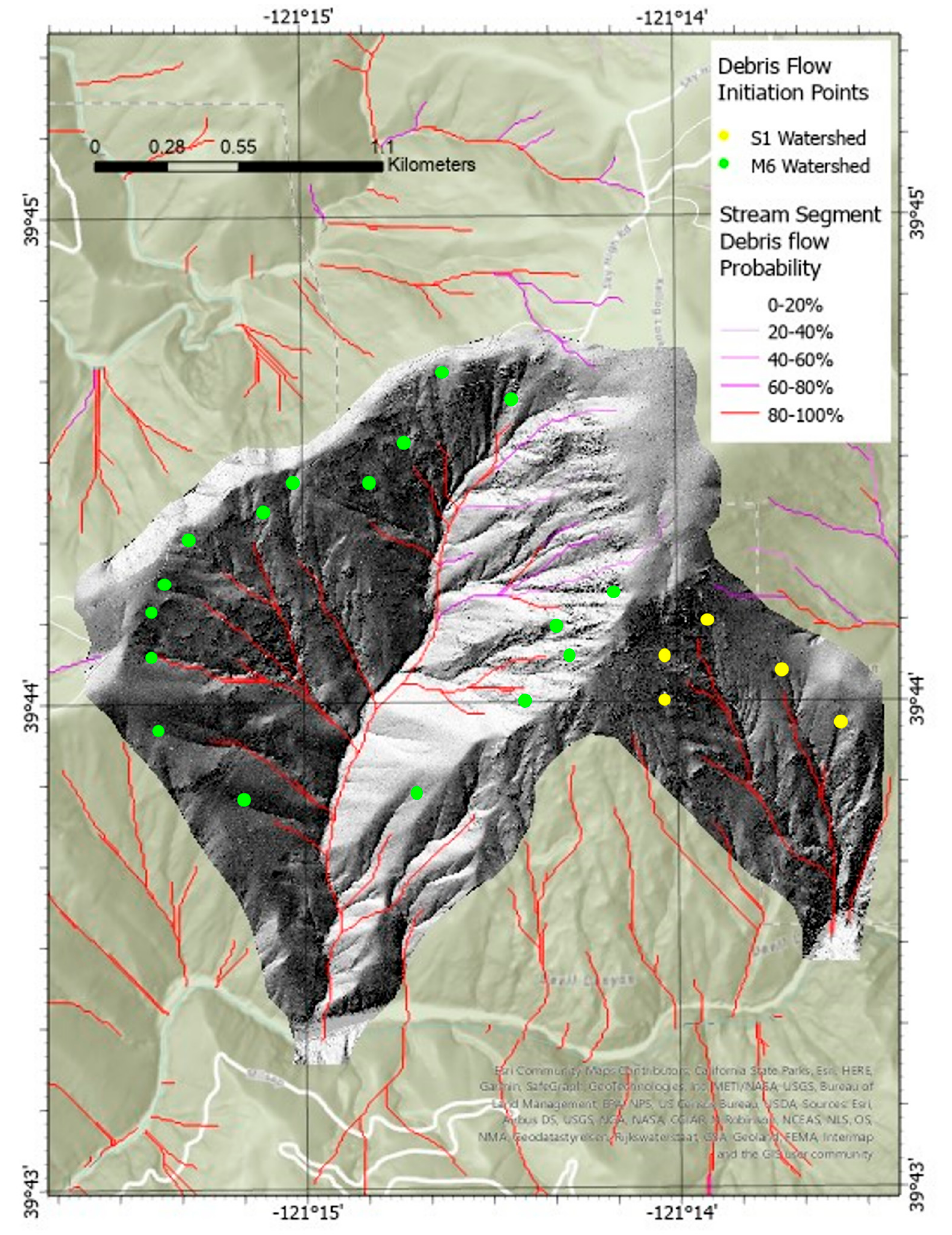
Figure 4. Debris flow initiation points from watershed M6 ( left ) and S1 ( right ).